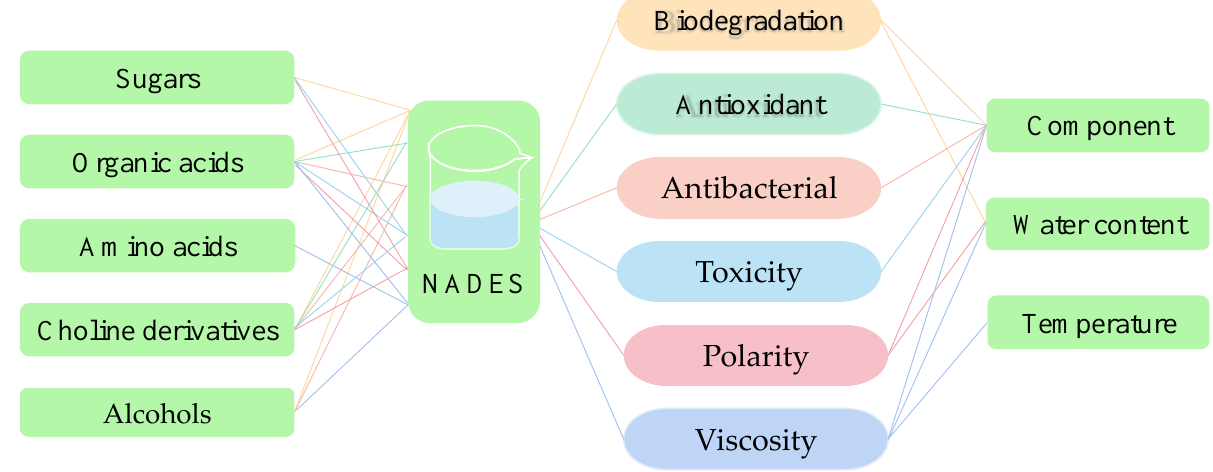
Figure 3. Properties and impact factors of NADES.